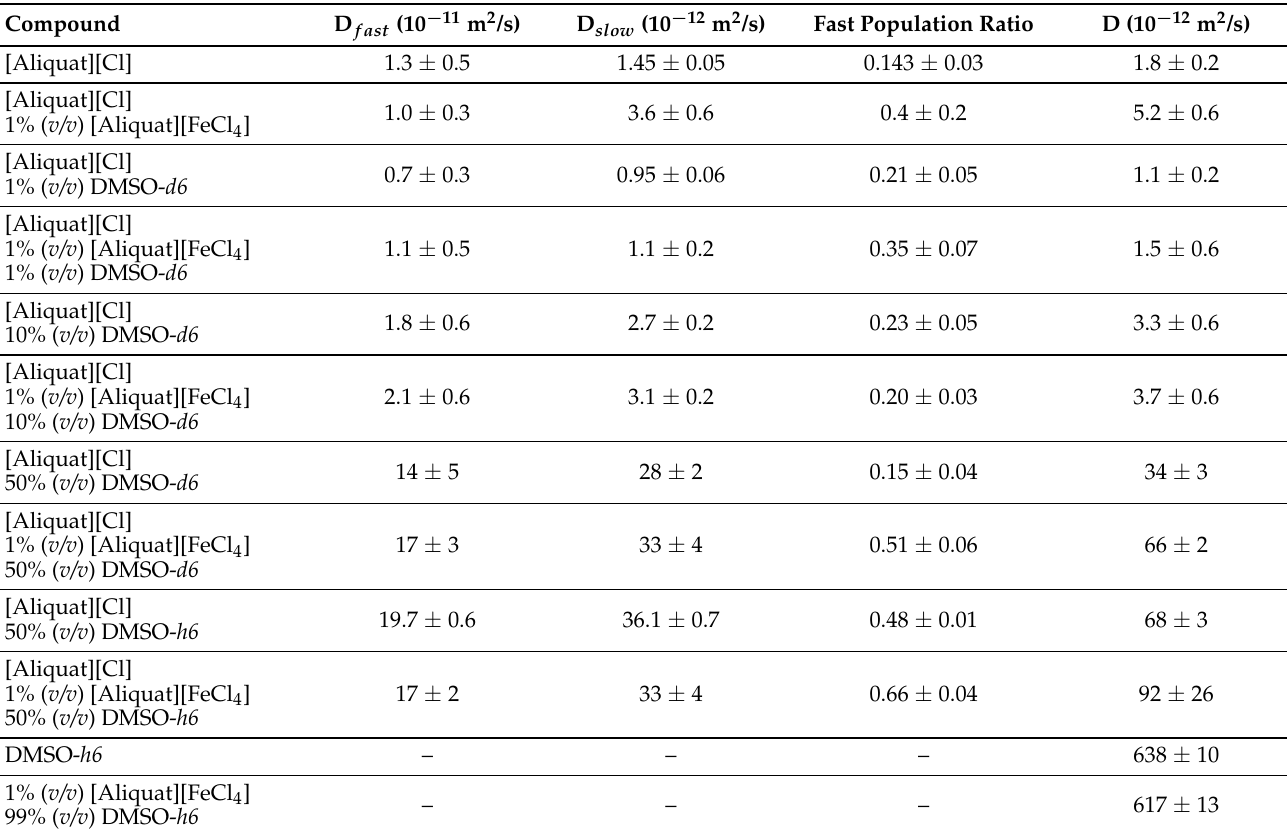
Table 3. Diffusion Coefficients obtained from the PGSE 1 H NMR experiments performed at 25 ◦ C. The uncertainties were determined using the value of χ 2 as an estimator of the variance, and D is an average contribution obtained from the fitting to a single